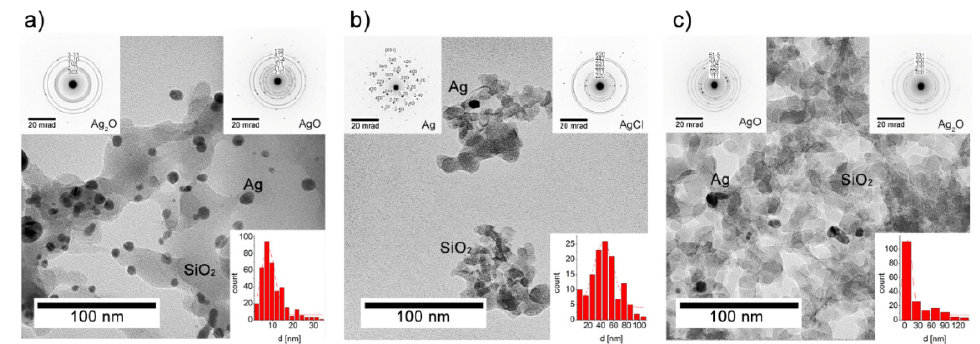
Figure 5. High resolution transmision electron microscopy (HRTEM) images of ( a ) the pure silver-silica nanocomposite and the chemically modified silver-silica derivatives; ( b ) Ag/SiO 2 @CMC and ( c ) Ag/SiO 2 @AS with an inset showing the selected area electron diffraction (SAED) patterns for Ag and the size distribution of Ag fitted by the Gaussian function. Table 3. Crystallographic data (lattice parameters, system, and space group) of the initial and modified silver-silica nanocomposites that were obtained based on the TEM + SAED data. Ag/SiO 2 Element